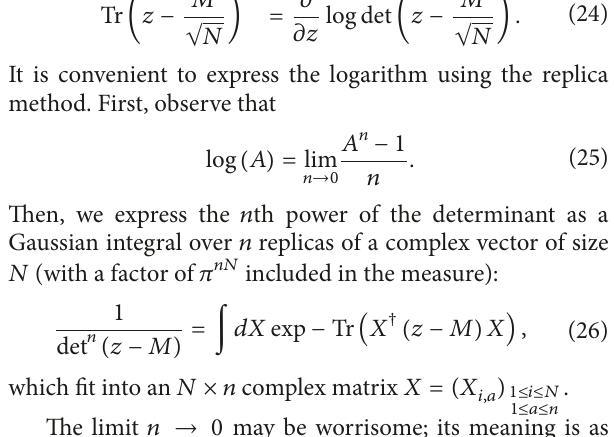
Figure 3: Graphical interpretation of the renormalisation group